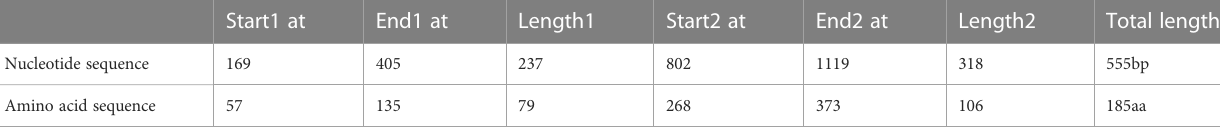
TABLE 1 Nucleotide and Amino acid positions of the selected Rv0934-555 enriched with T-cell epitopes.